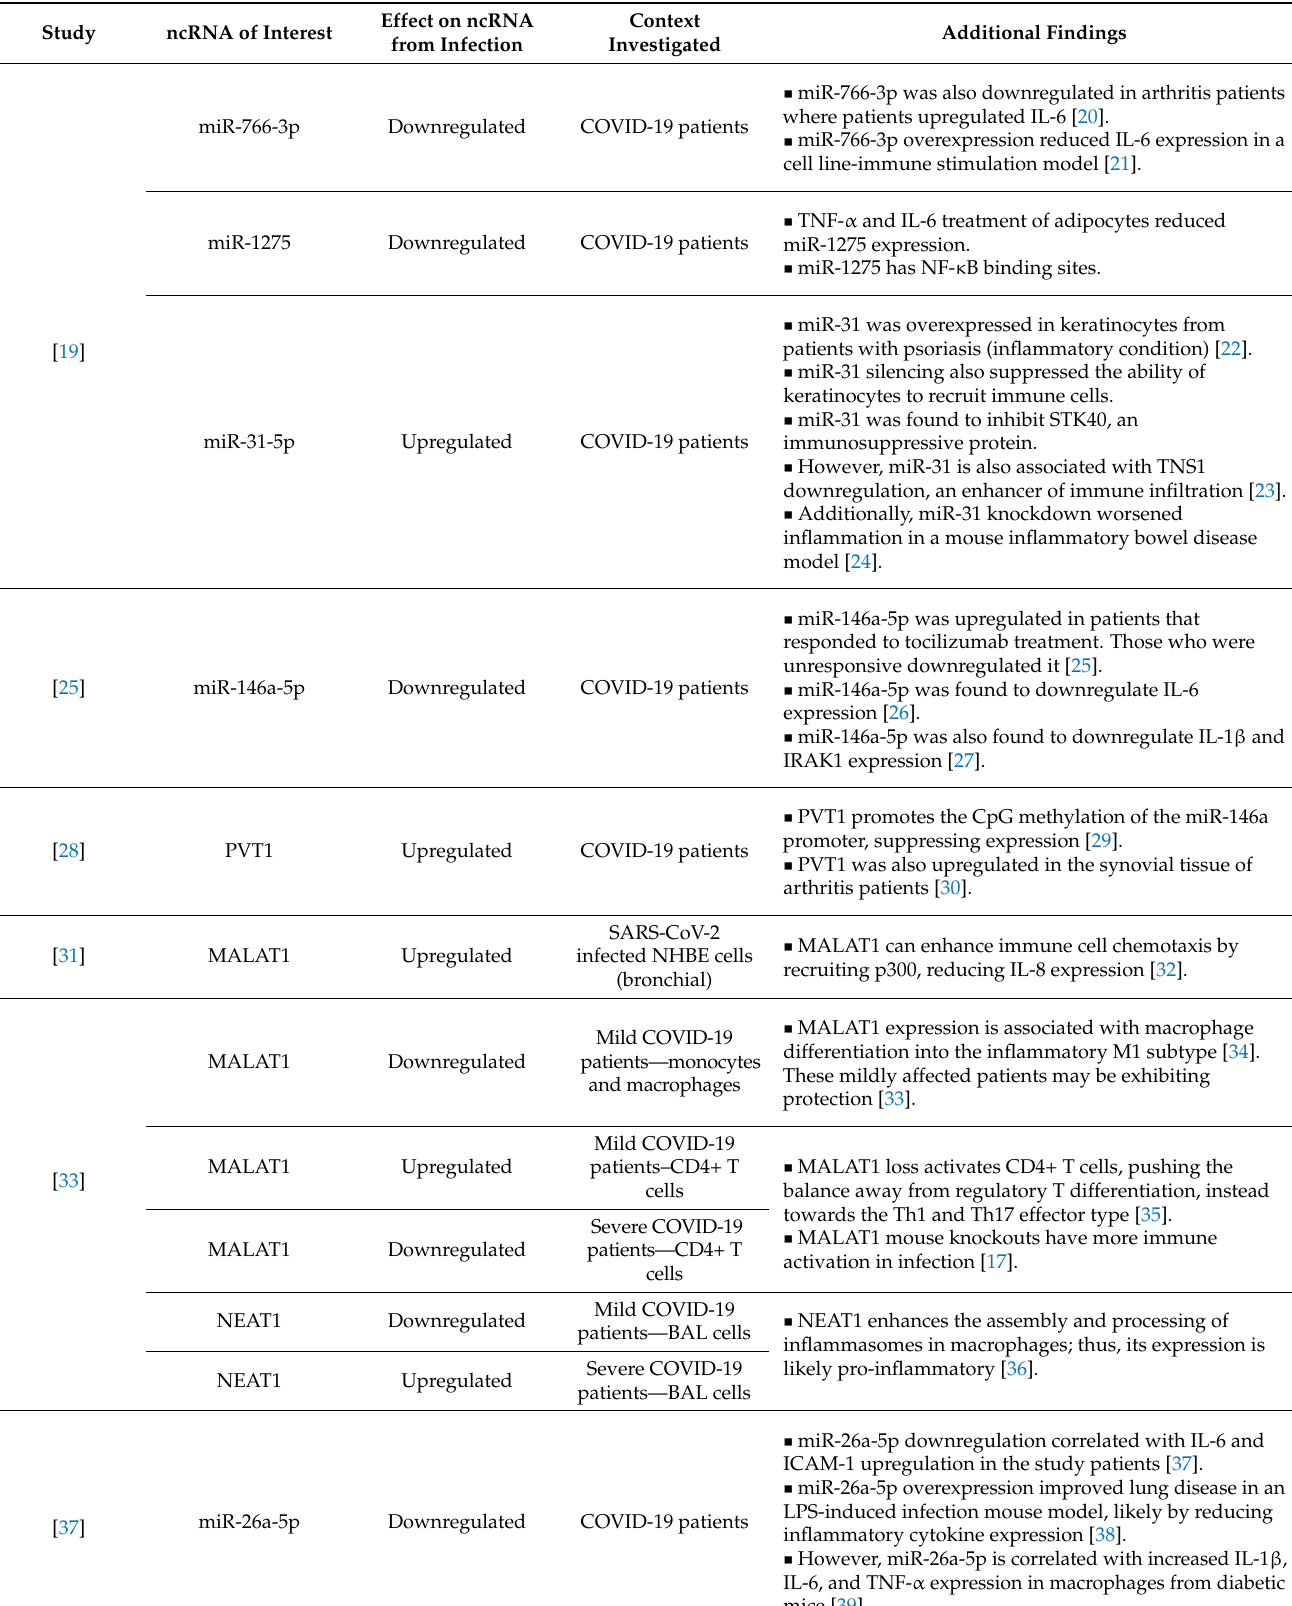
Table 1. A summary of the published COVID-19 ncRNA profiling studies with relevant literature highlighted.